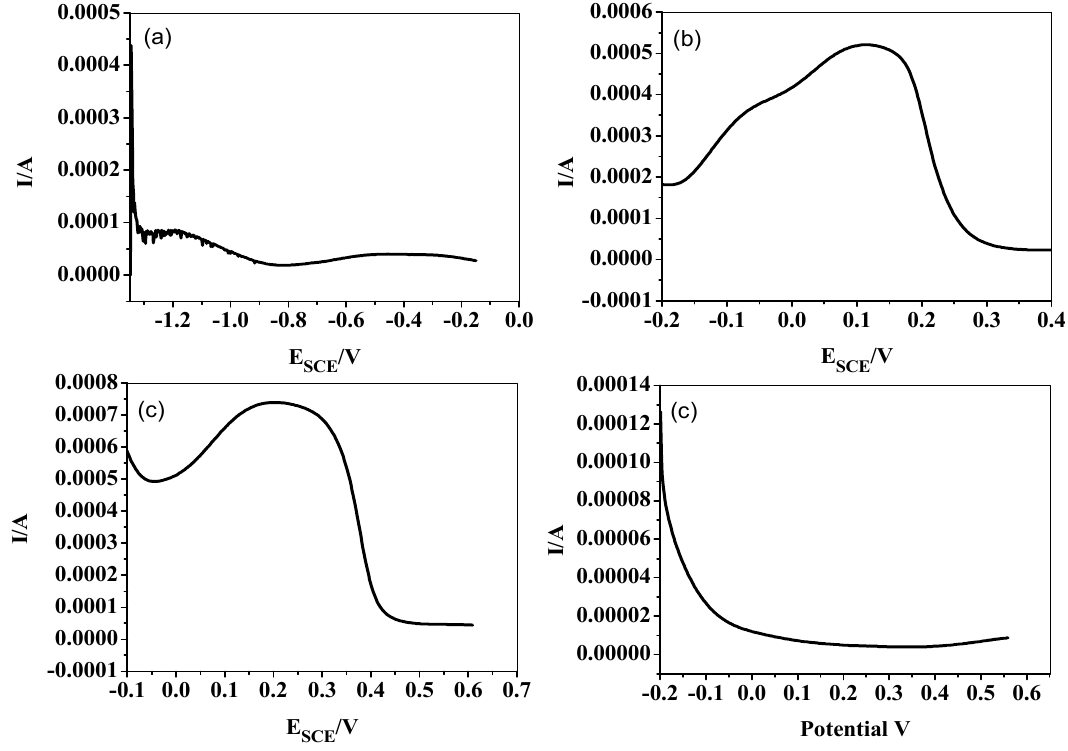
Figure 6. Differential pulse voltammograms (DPVs) of ( a ) bare as well as ( b ) PACHA-, ( c ) PANI-, and ( d ) PHA-coated electrodes in citrate buffer (pH 5) containing 1.4 × 10 − 6 M H 2 O 2 solution.